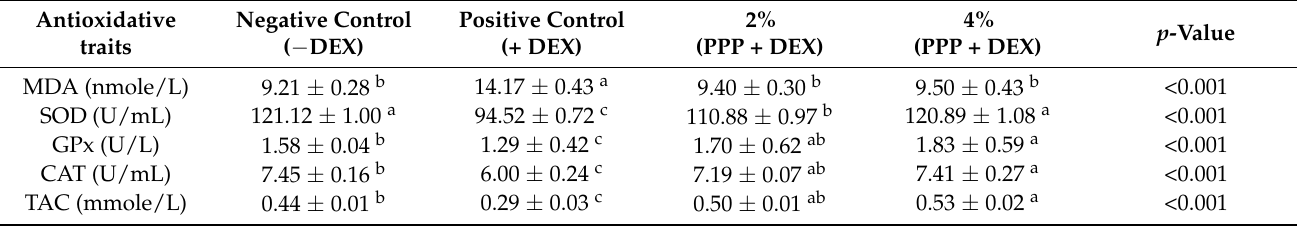
Table 6. Effect of different levels of dietary pomegranate peel on antioxidative indicators of laying hens subjected to oxidative